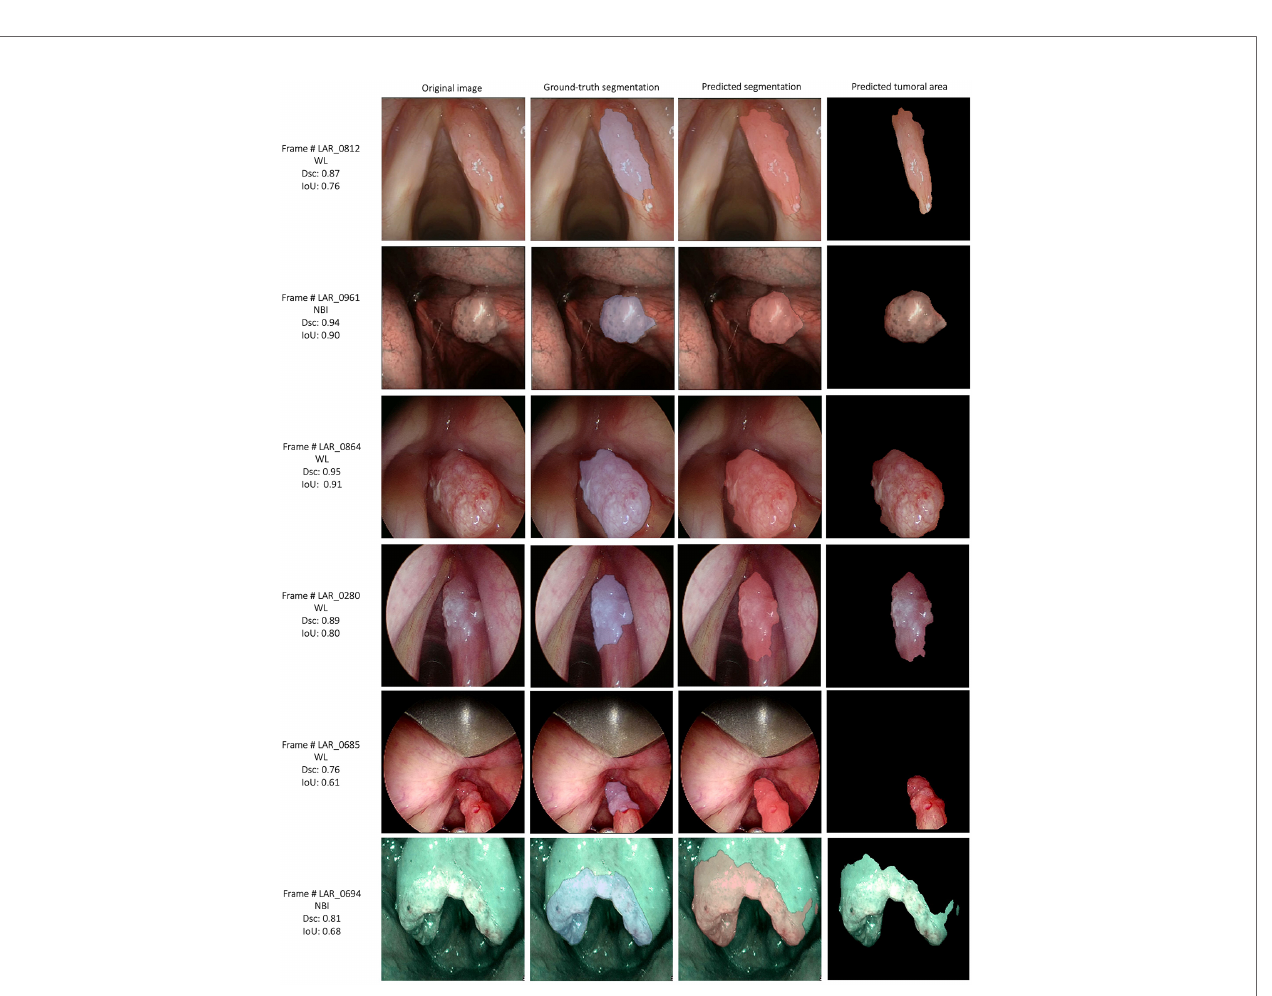
FIGURE 8 | Examples of automatic segmentation results for the laryngeal squamous cell carcinoma dataset using SegMENT ensemble. DSC, dice similarity coef fi cient; IoU, intersection over union; WL, white light; NBI, Narrow Band Imaging.